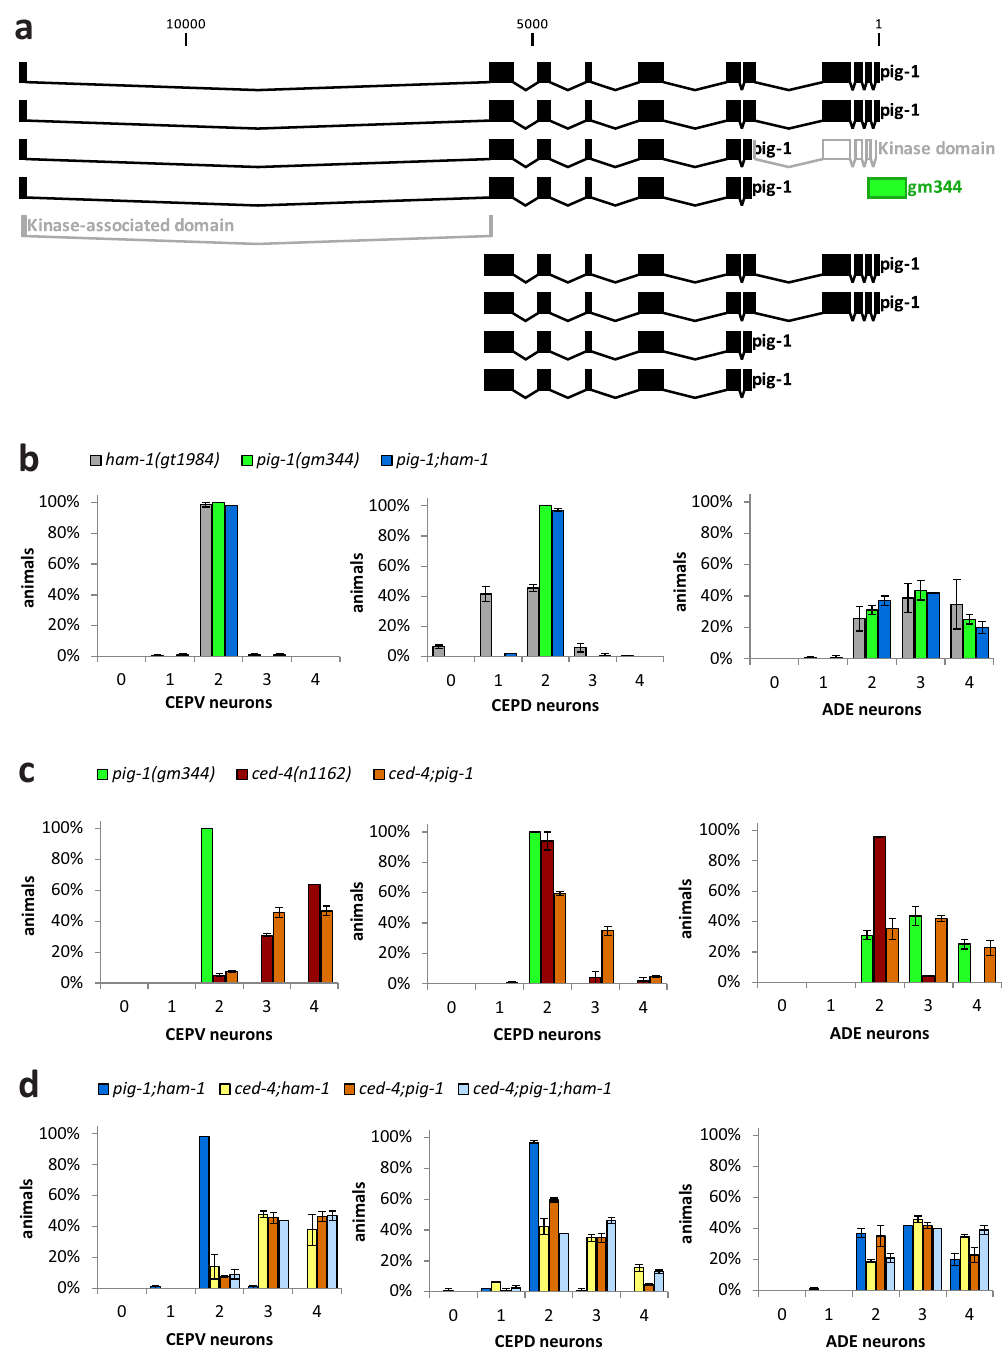
Figure 2. pig - 1 is epistatic to ham - 1 in the CEPD neuron lineage and genetically interacts with the apoptosis pathway. ( a ) pig - 1 gene structure with position of the predicted kinase and kinase-associated domains (both in white) and the pig - 1 ( gm344 ) 562 bp deletion (in green). In gm344 , 400 bp of the pig - 1 promoter and the first 132 bp of the kinase domain are deleted. ( b ) Number of dopaminergic head neurons in the ham - 1 , pig - 1 and pig - 1 ; ham - 1 mutant. ( c ) Number of dopaminergic head neurons in the pig - 1 , ced - 4 and ced-4;pig-1 mutant. ( d ) Number of dopaminergic head neurons in the double and triple mutants of ham - 1 , pig - 1 and ced - 4 . Error bars = SEM of 2–4 biological replicates with 50 animals